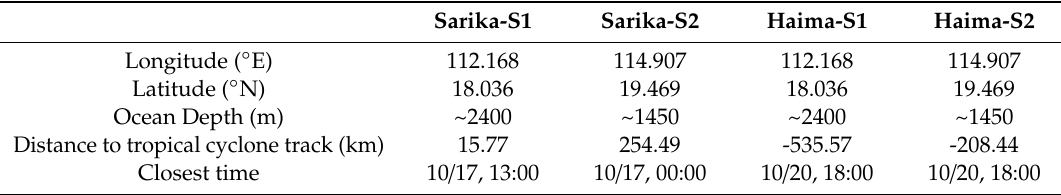
Table 4. Details of Typhoons Sarika and Haima when closest to Stations 1 and 2 *.